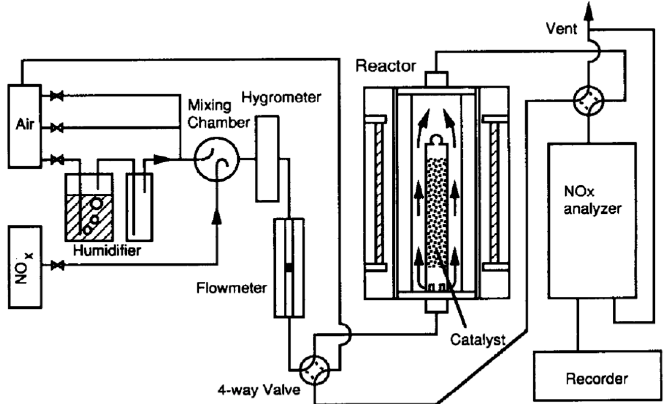
Figure 15. Schematic diagram of the flow-type reactor used for the heterogeneous photocatalytic reductions of NO x agents. Experimental conditions: 1–2 ppm NO/NO 2 ; flow rate, 500 mL min − 1 for 5–10 h at different relative humidity (dry to 72%); reactor volume, 126 mL; pure O 2 or purified air; reaction temperature, ca. 310 K. Reproduced with permission from Ibusuki and Takeuchi [97].